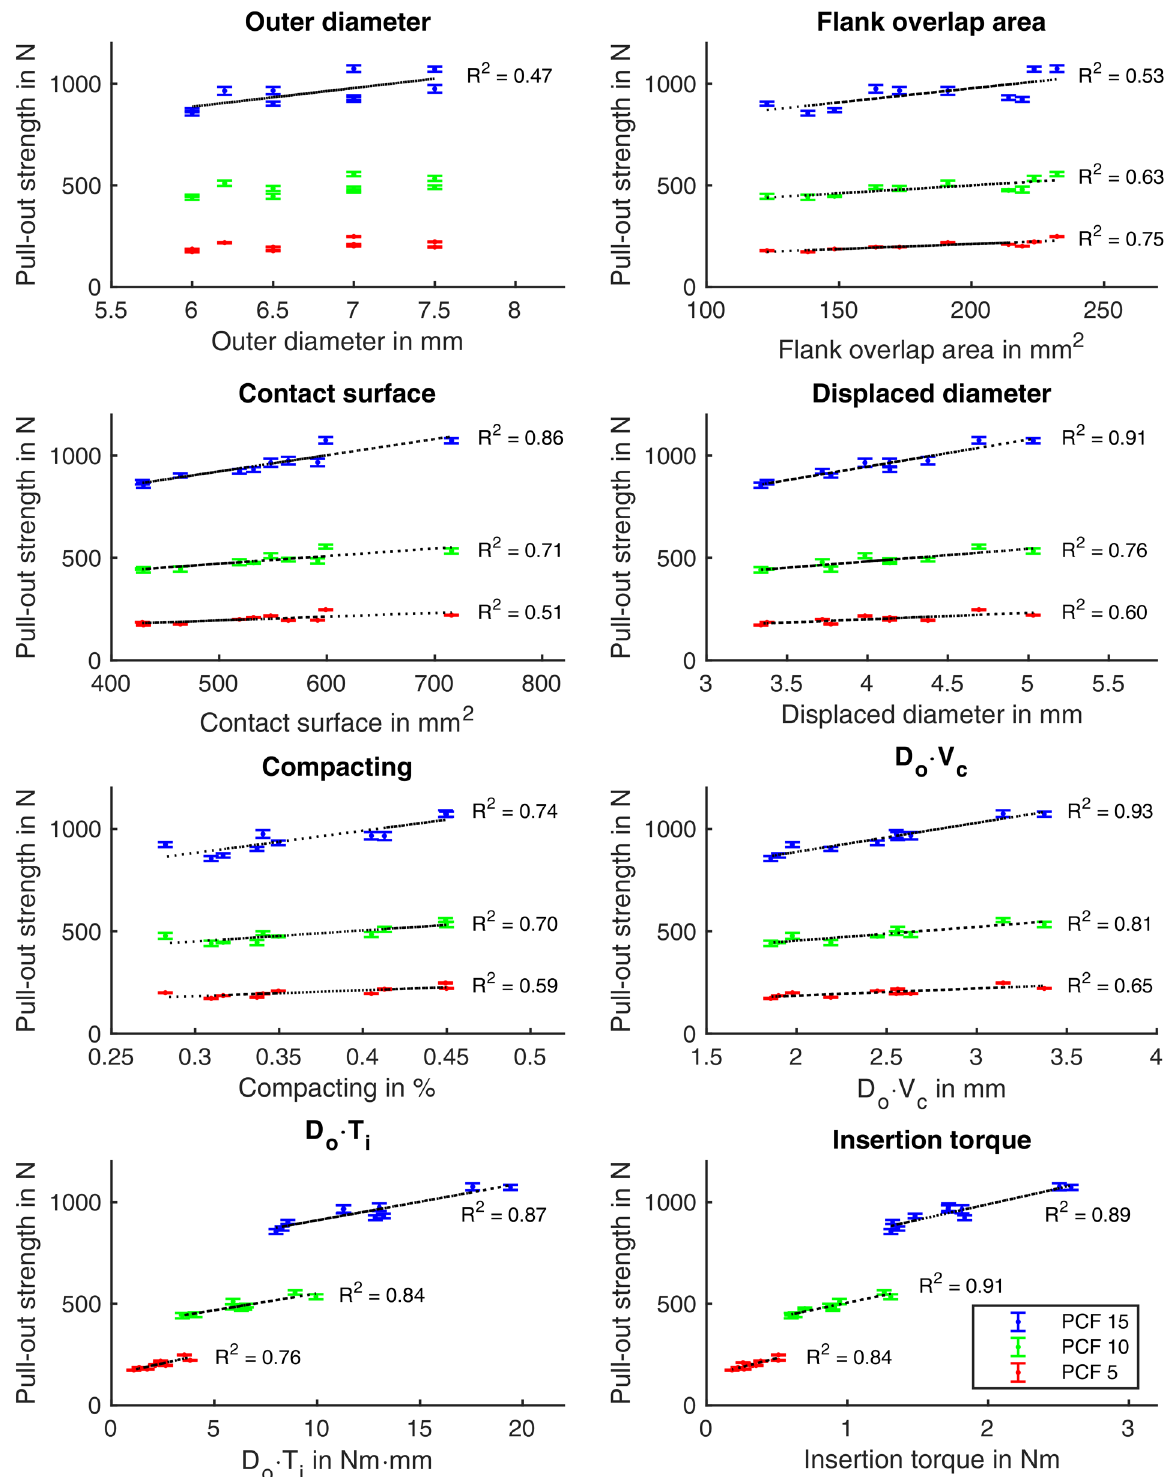
Figure 3. Comparison of different screw characteristics with the achieved pull-out strength for screws with tapered core. Shown are the mean values with error bars of one standard deviation for PCF 15 (blue), PCF 10 (green) and PCF 5 (red). If there was a statistically significant linear correlation, the coefficient of determination R 2 is